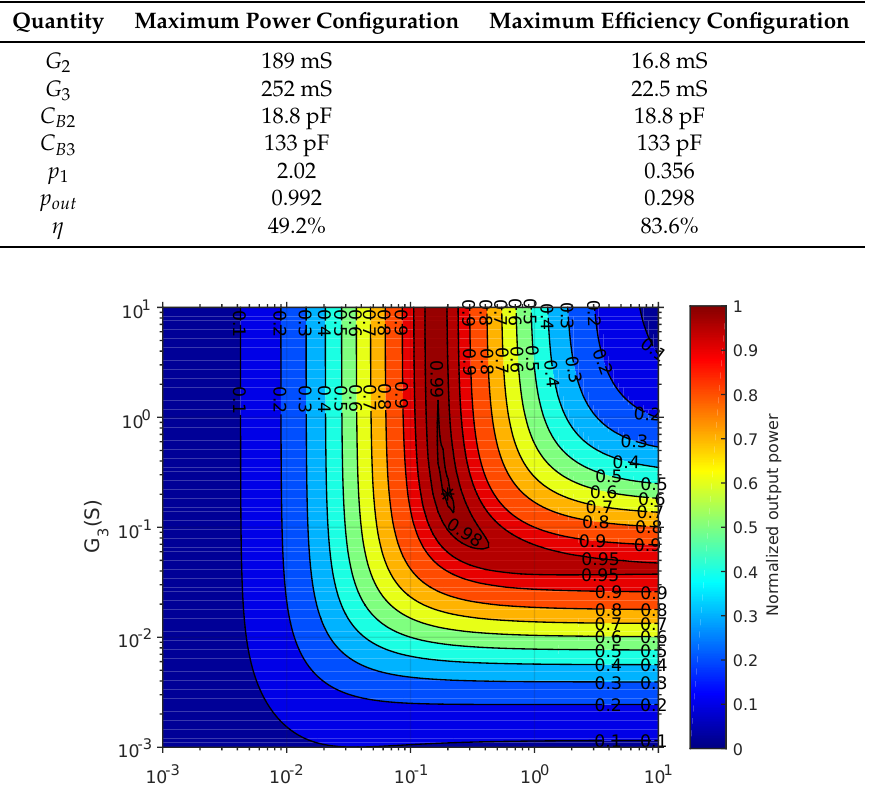
Table 4. Calculated values for the considered capacitive wireless power transfer (CWPT) system for the maximum power and the maximum efficiency configuration.